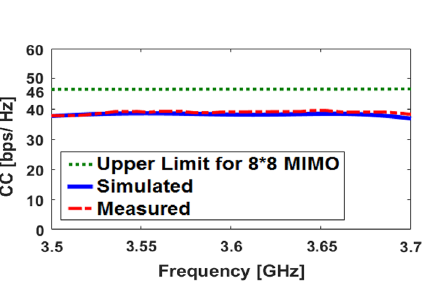
Figure 17. Calculated channel capacity for the corresponding